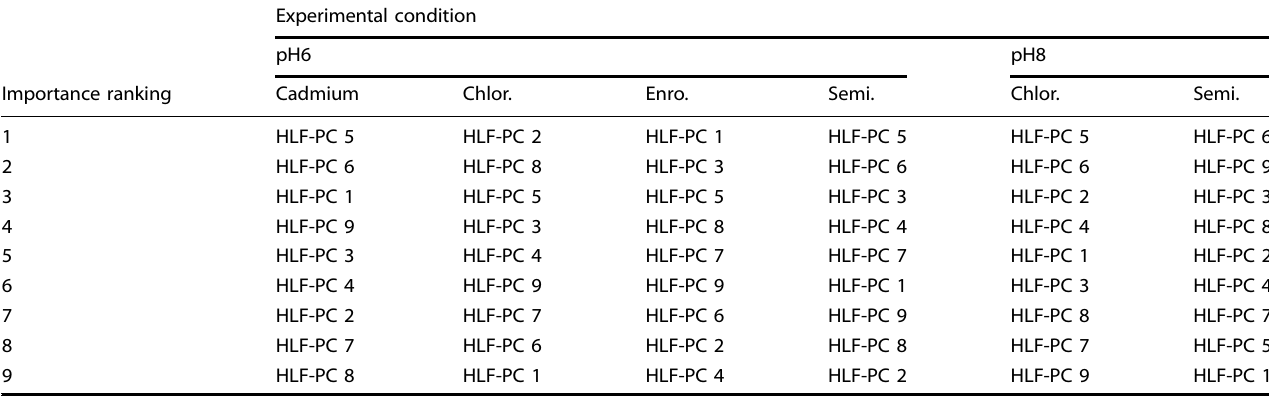
Table 3. Importance ranking of features for each experimental